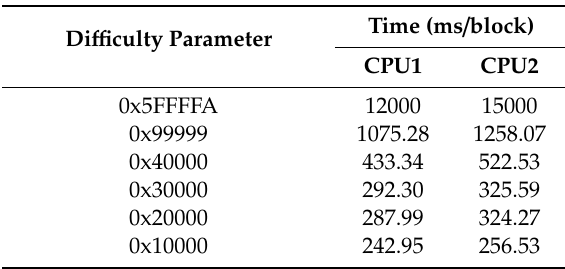
Table 2. Time for data onto